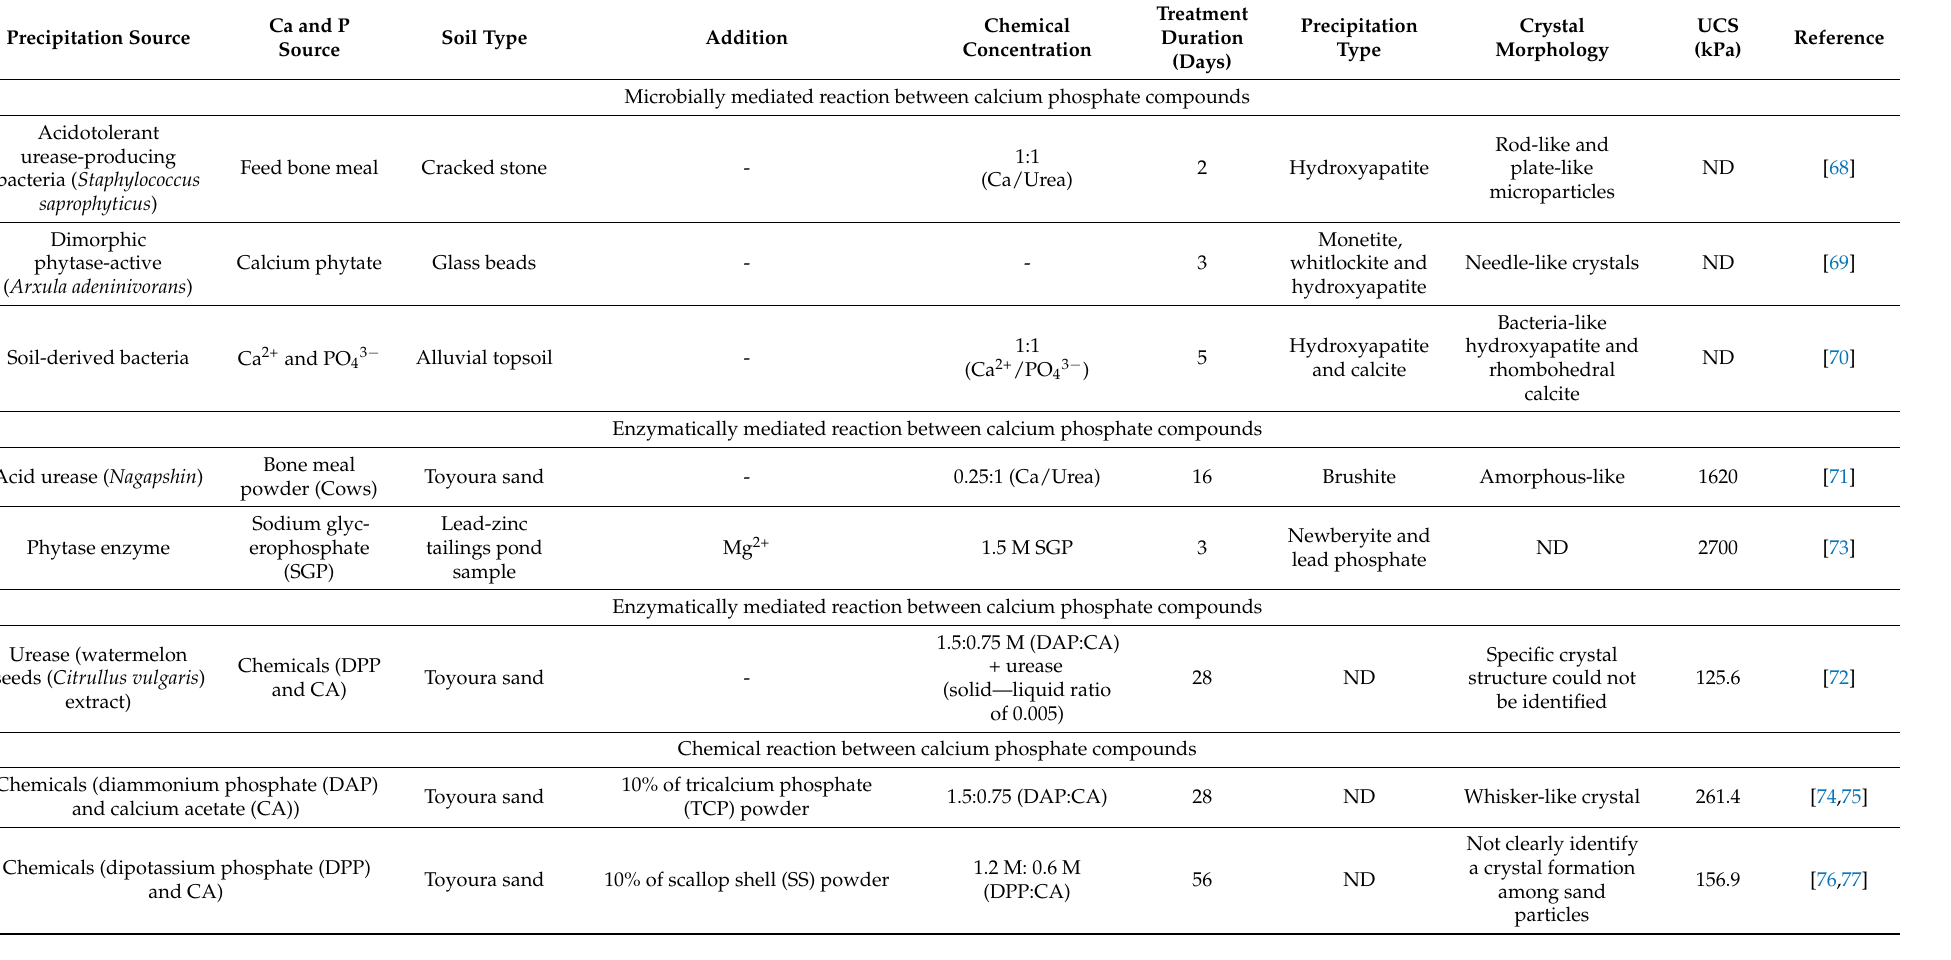
Table 1. Previous studies on soil improvement using calcium phosphate